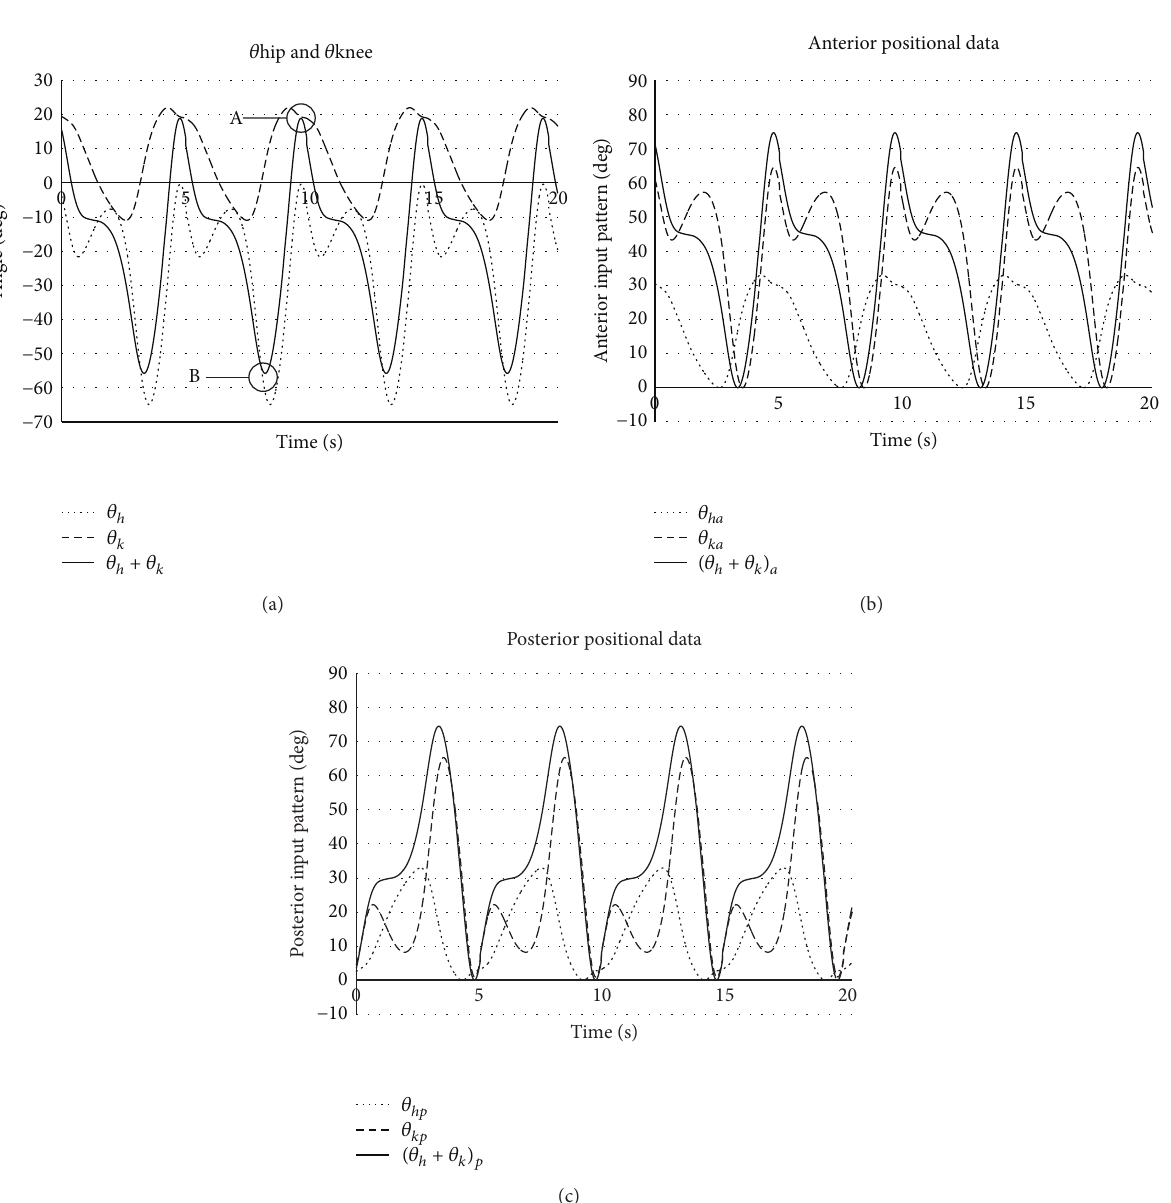
𝜃 𝜃 (𝜃 + 𝜃 ) ℎ𝑝 , 𝑘𝑝 , and ℎ 𝑘 𝑝 are the positional data for the posterior